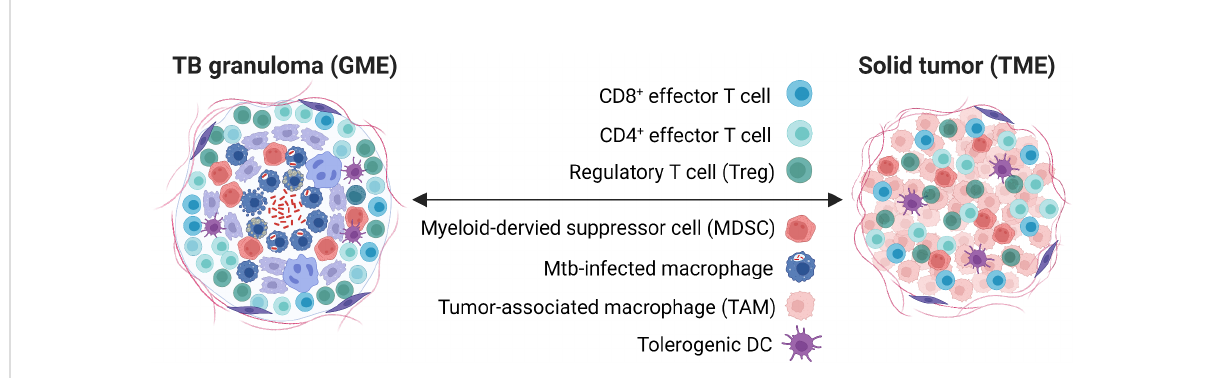
FIGURE 1 The TB granuloma versus solid tumor microenvironment. Shown are relevant immune cells involved with a focus on myeloid cells and T cell subsets, several with immunosuppressive functions that are controlled by checkpoint molecules. Light purple cells in the TB granuloma depict epithelioid cells and multinucleated giant cells, while dark purple cells depict fi broblasts. GME, granuloma microenvironment; TME, tumor